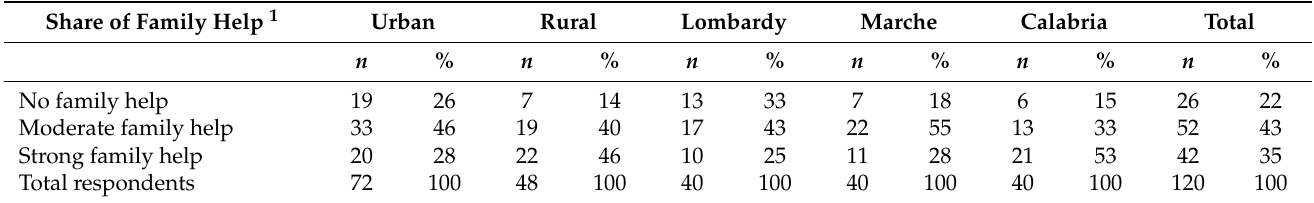
Table 7. Share of family help on the total, by sites and regions.